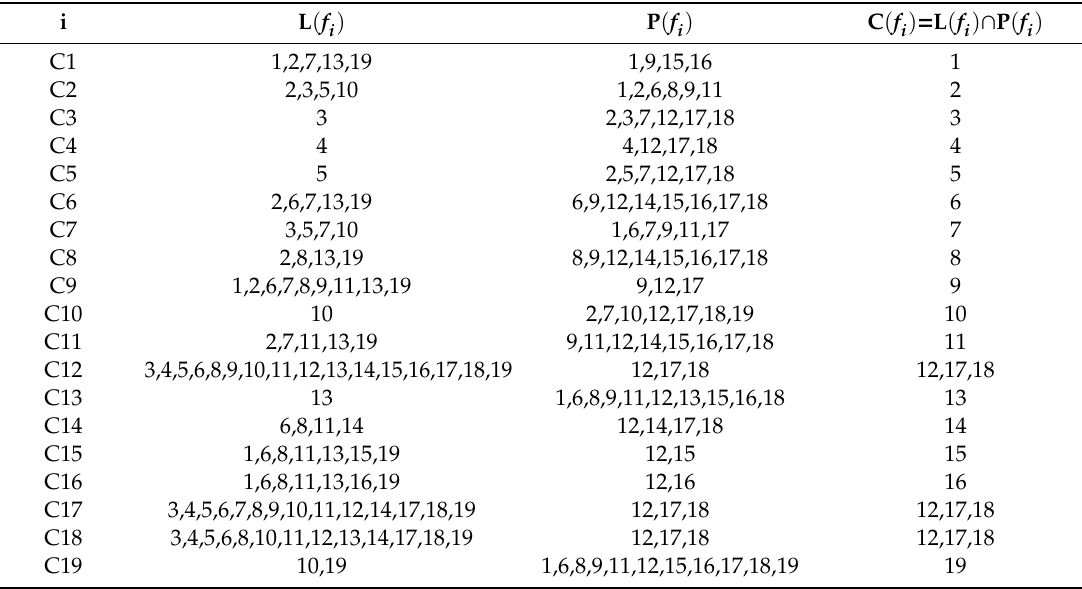
Table 8. First-level decomposition